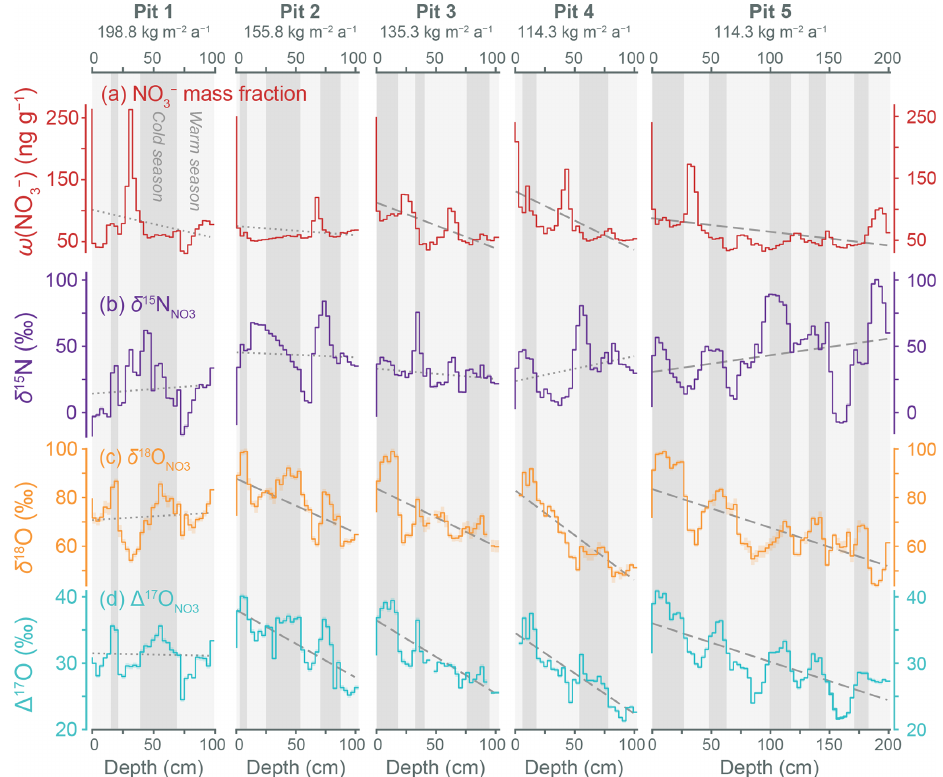
− ) (a) and NO − isotopic values (b–d) with snow depth for five pits sampled along the CHICTABA traverse. Figure 4. Changes in ω (NO 3 3 The modeled surface mass balances (Agosta et al., 2019; Amory et al., 2021) for different pit sites are given at the top of each plot. Dashed and dotted gray lines show a linear regression (variable vs. depth) fitted to each set of data (Table S1 in the Supplement). Dashed lines represent regressions whose f-statistic p value < 0.05, and dotted lines represent regressions whose f-statistic p value ≥ 0.05. Gray shaded backgrounds indicate inferred seasonal cycles (darker = colder months of ∼ May–October, lighter = warmer months of ∼ November–April) based primarily on when residuals of the (cid:49) 17 O NO regression are positive (i.e., (cid:49) 17 O NO peaks). Measurement uncertainties in isotopic 3 3 values are displayed as colored shaded zones around the stepped lines but are too small to be visible on most